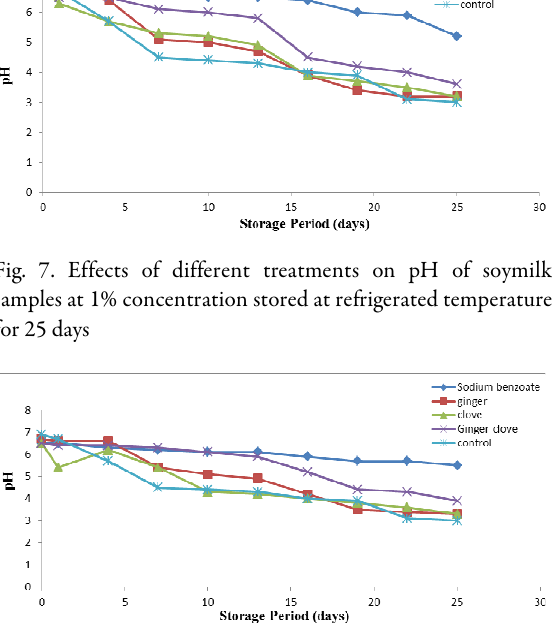
Fig. 9. Effect of different treatments on the pH of soymilk samples at 5% concentration stored at refrigerated temperature for 25 days